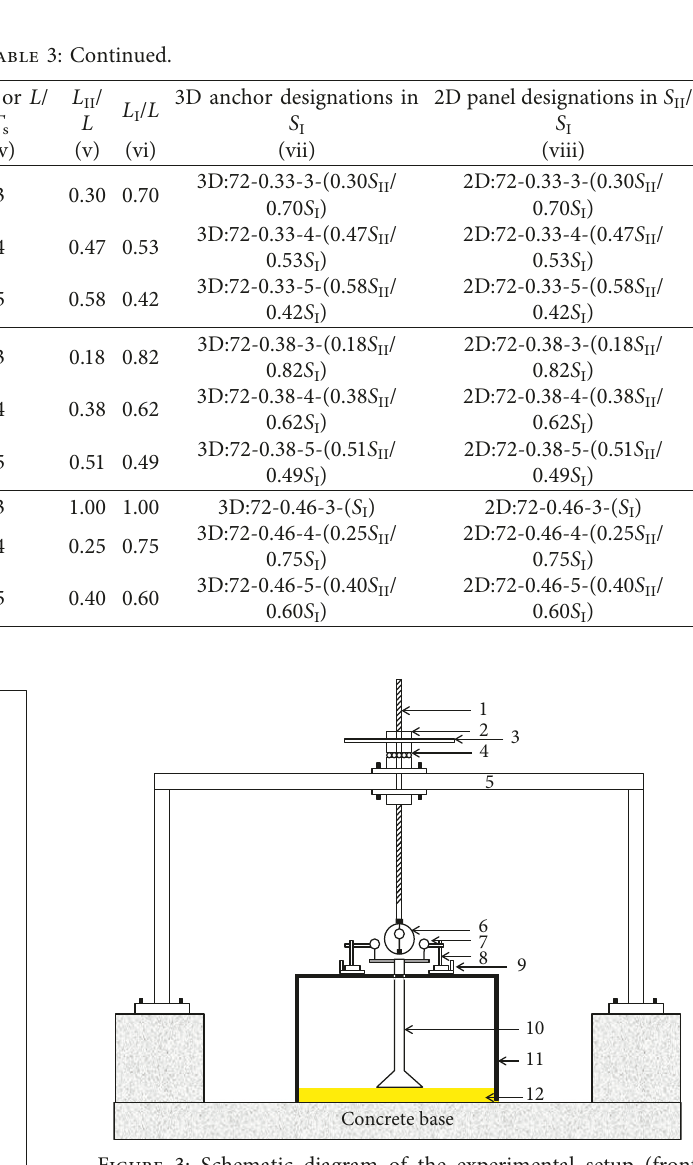
Figure 3: Schematic diagram of the experimental setup (front view): (1) long screw, (2) nut, (3) rotating wheel, (4) ball-bearing arrangement, (5) reaction frame, (6) proving ring, (7) dial gauge, (8) magnetic base, (9) magnetic base fixture, (10) model anchor, (11) model tank, and (12) sand